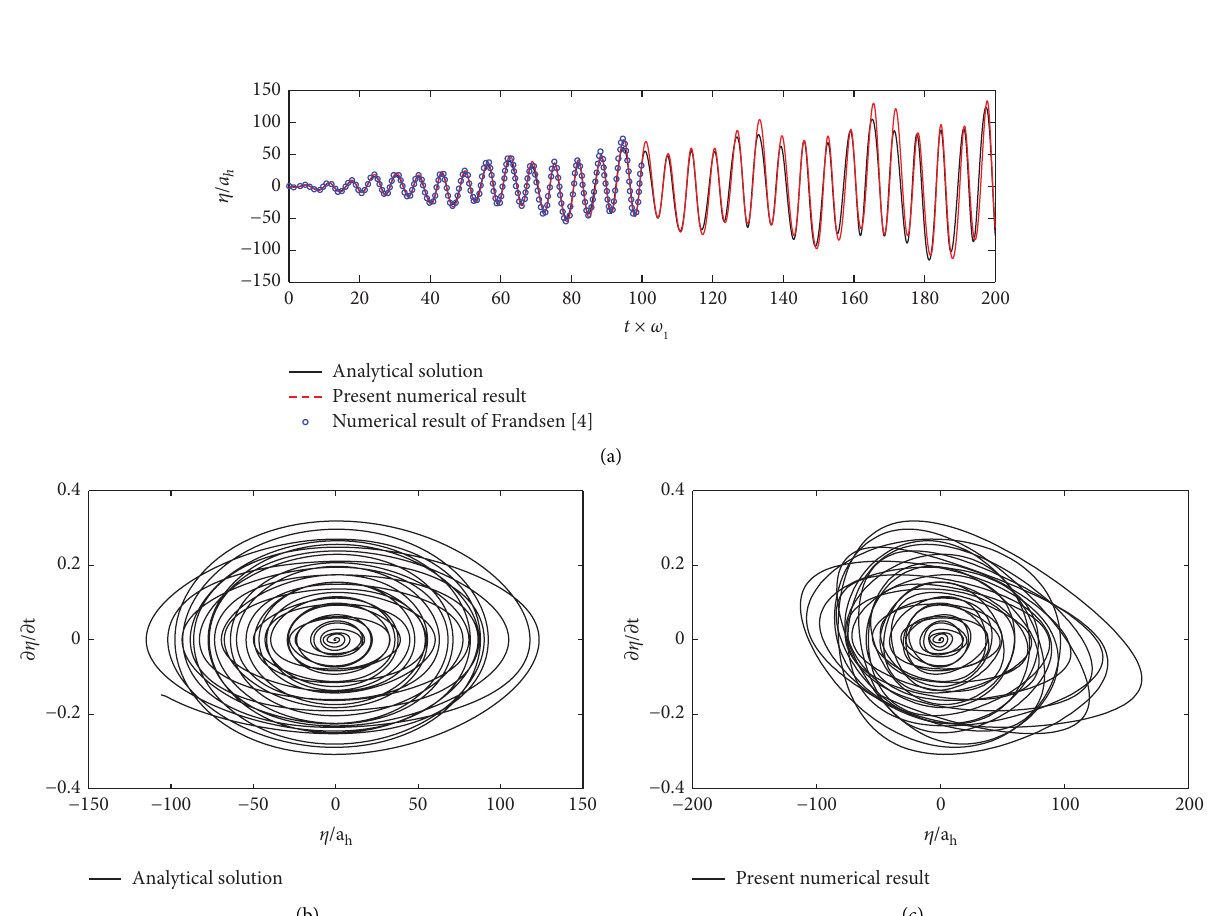
Figure 2: (a) Comparison of the nondimensional time histories of the free surface displacements at the left wall among the analytical solution (solid line), the present numerical result (dash line), and the numerical result of Frandsen [4] (circle). The phase-plane charts: (b) analytical solution and (c) present numerical result.